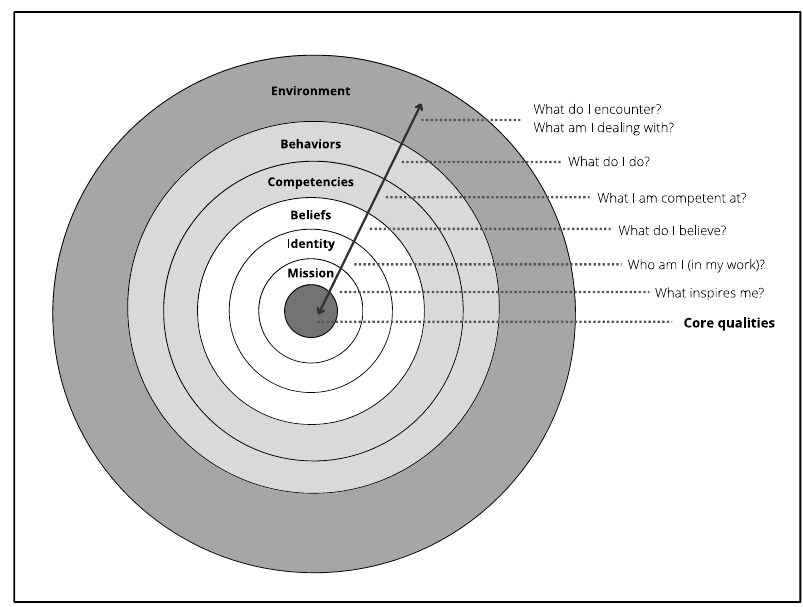
Figure 1. Onion Model—Level of Change (Korthagen 2004).